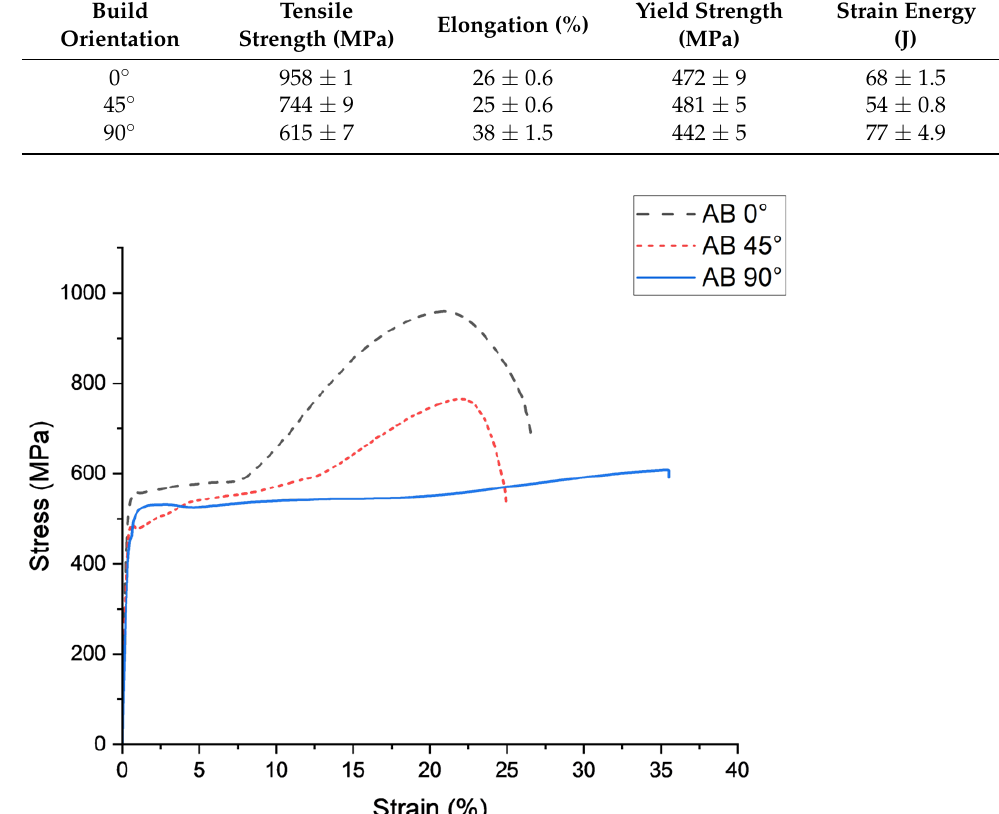
Figure 18. The direction of the melt pool boundary for each build direction respective to the load direction.